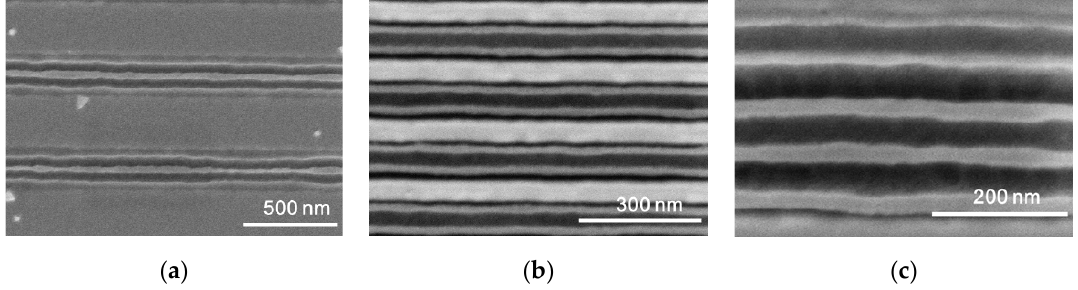
Figure 5. SEM micrographs of PMMA etched lamellar PS- b -PMMA block copolymer on silicon substrates pre-coated with PS- b -PMMA. Line widths on these topographically patterned substrates were ( a ) 300 nm, ( b ) 100 nm, and ( c ) 300 nm, respectively.